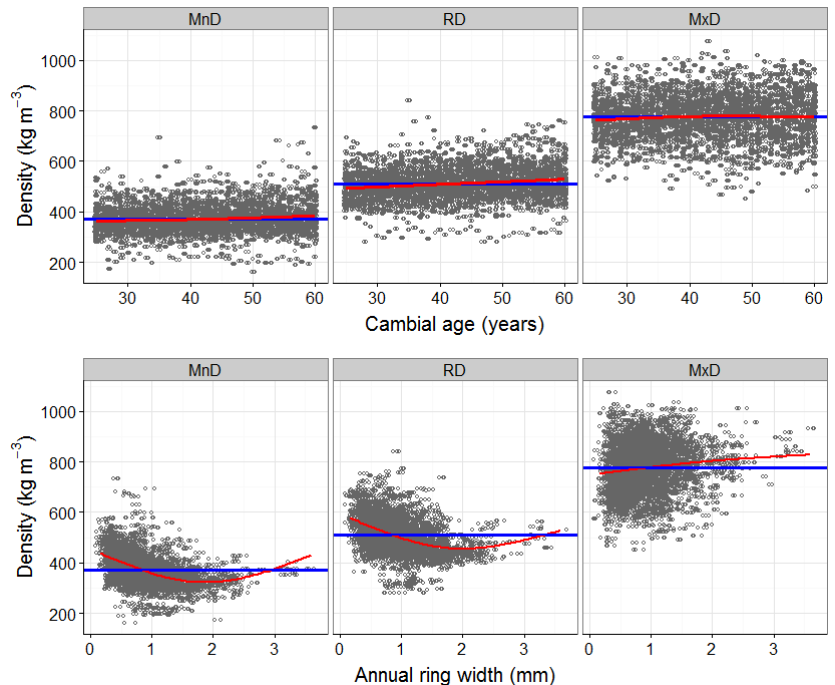
Figure A1. Minimum, mean and maximum ring density against cambial age and ring width. The red lines represent the mean predictions from model 1 for each density component (Tables 3–5), and the blue lines represent the overall mean